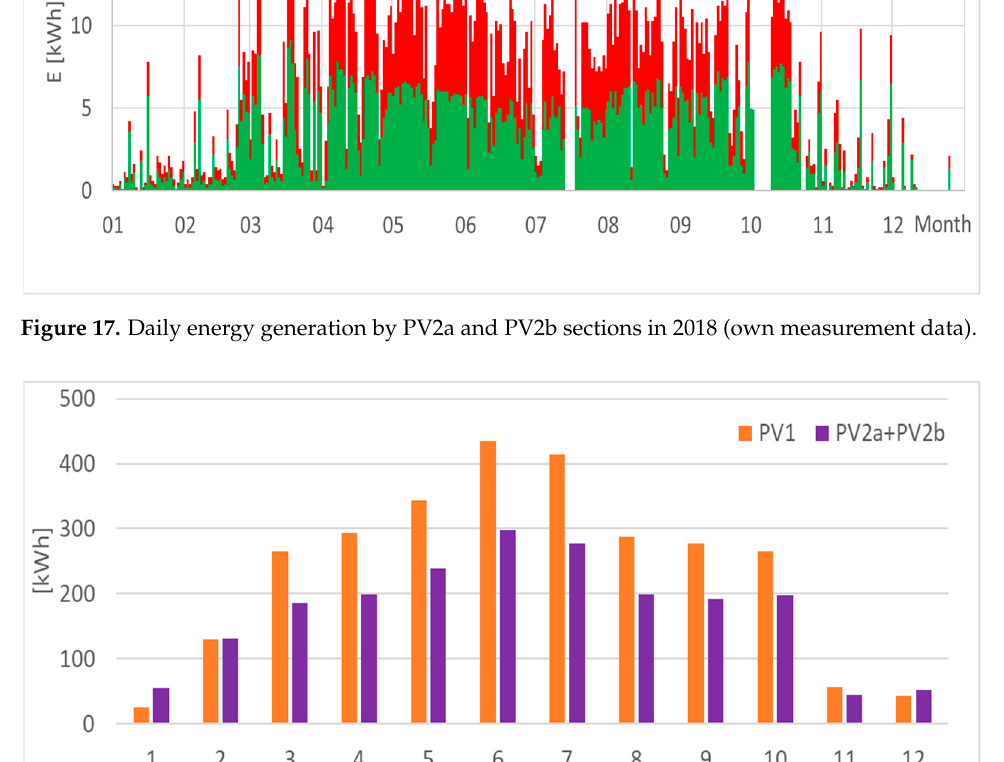
Figure 18. Monthly energy generation by PV1 and PV2a+PV2b sections in 2021 (own measurement data).